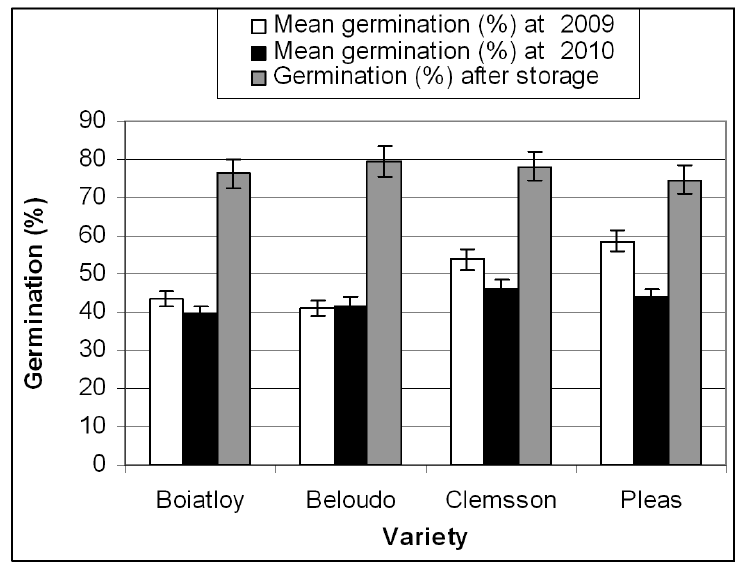
Fig. 2. Effects of variety and seed storage on germination in 2009 and 2010